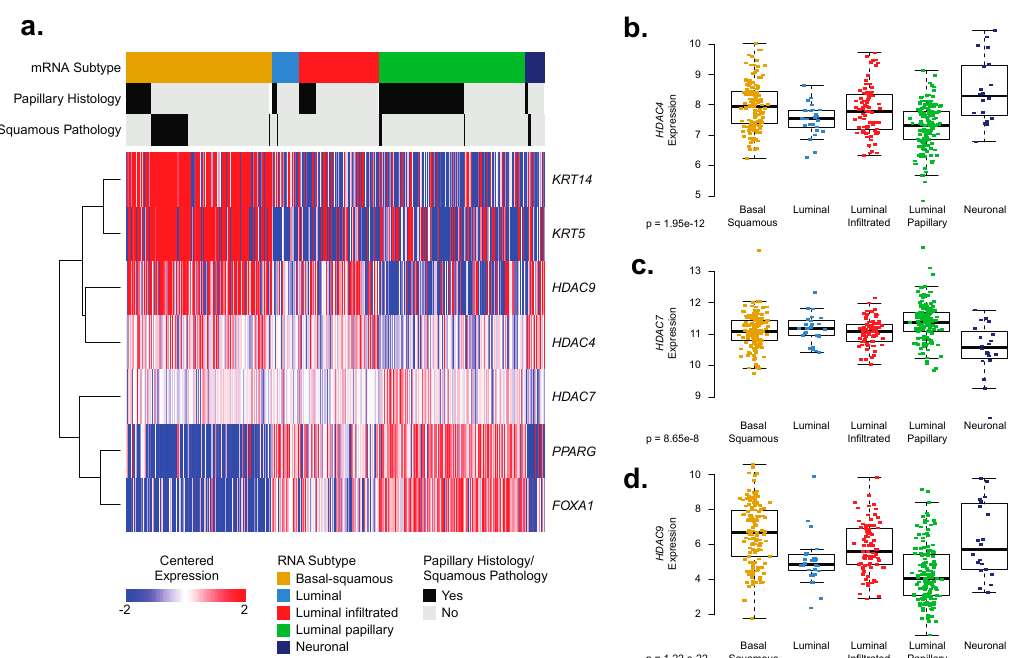
Figure 4. Histone deacetylase (HDAC4) and HDAC9 expression co-clusters with basal markers in muscle-invasive bladder cancer (BC). ( a ) Heat map display of expression values (log2(normalized RSEM + 1)) from the Cancer Genome Atlas (TCGA) bladder cancer cohort ( n = 408) for HDAC4 , HDAC7 , and HDAC9 , as well as select genes that serve as markers of luminal (forkhead box A1 ( FOXA1 ), peroxisome proliferator-activated receptor gamma ( PPARG )) and basal ( KRT14 , KRT5 ,) BC. Hierarchical clustering was applied after median centering the expression values by gene. Annotation tracks show gene expression subtype, histological subtype, and squamous pathology classification. ( b ) HDAC4 is overexpressed in neuronal, basal-squamous, and luminal infiltrated subtypes. ( c ) While statistically significant among subtypes, HDAC7 occurs as decreased expression in neuronal subtypes and increased in luminal papillary subtypes. ( d ) HDAC9 is overexpressed in basal–squamous and luminal infiltrated